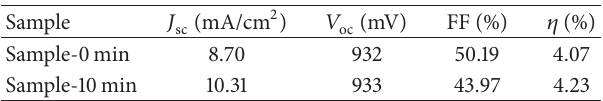
Table 3: Experiment parameters of the optimum MPSCs depending on the drying time of 0min and